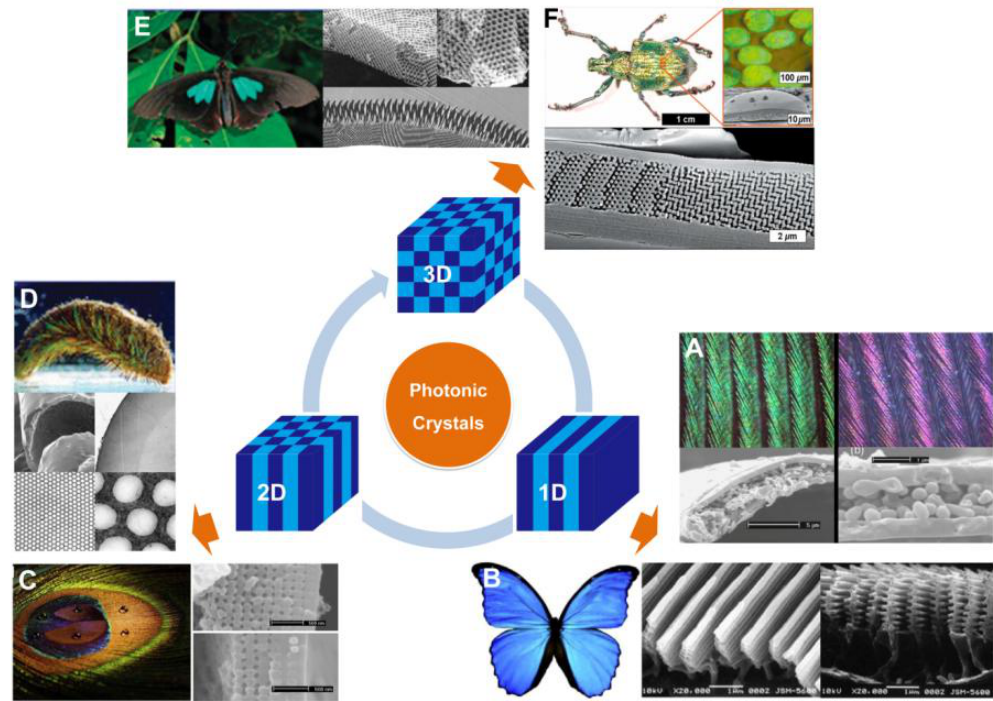
Figure 2. Typical naturally occurring photonic structures with various structural